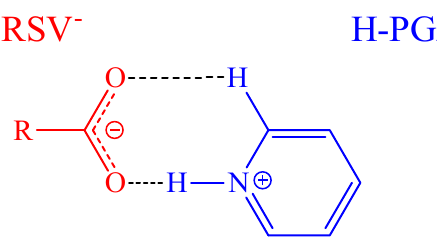
Figure 3. Molecular recognition − COO − ··· + H-N pyr (synthon).